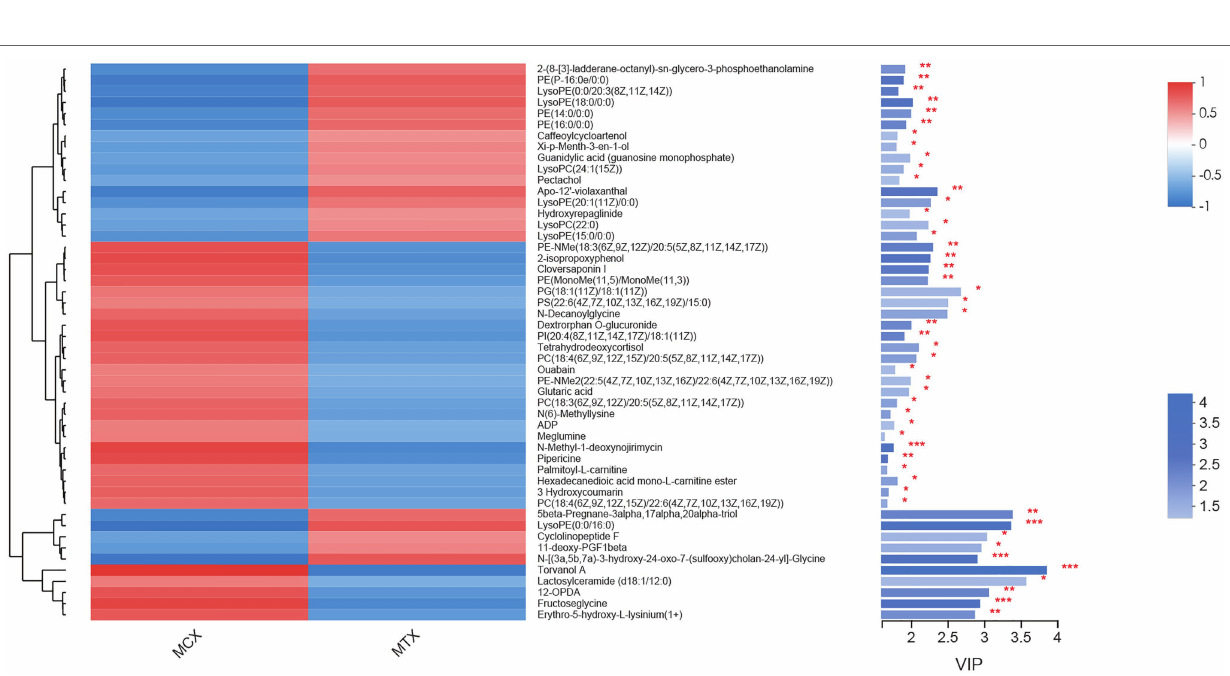
FIGURE 4 | Fifty metabolites with the highest variable importance in projection (VIP) spectrograms under hierarchical cluster analysis. The metabolite cluster dendrogram is on the left. The closer the branch, the closer the expression patterns of all metabolites in different groups; on the right is the VIP bar graph of metabolites. The length of the bar represents the contribution value of the metabolite to the difference between the two groups. The default value is not less than 1. The larger the value, the greater the difference between the two groups. The color of the bar indicates that the metabolites are significantly different ( P -value) in the two sets of samples. P -value < 0.001 was marked as ***, P -value < 0.01 was marked as **, and P -value < 0.05 was marked as